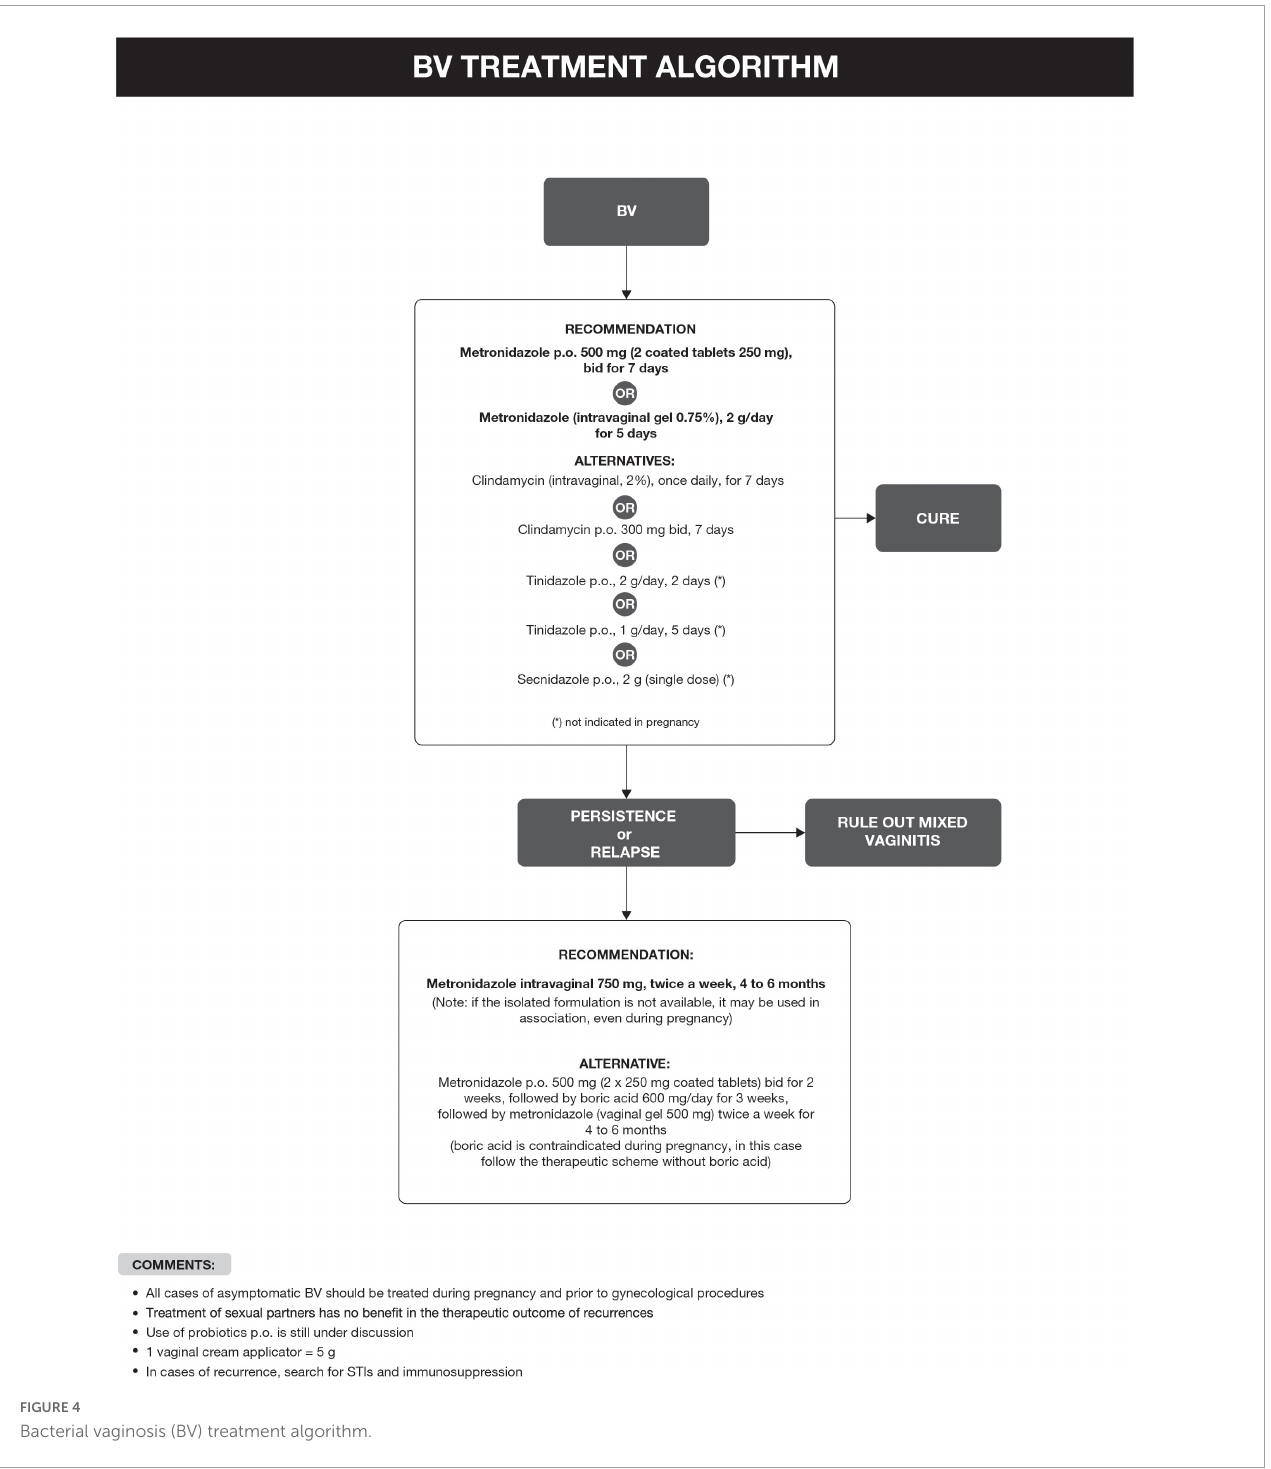
cervicitis include Chlamydia trachomatis, Neisseria gonorrhoeae , and Mycoplasma genitalium